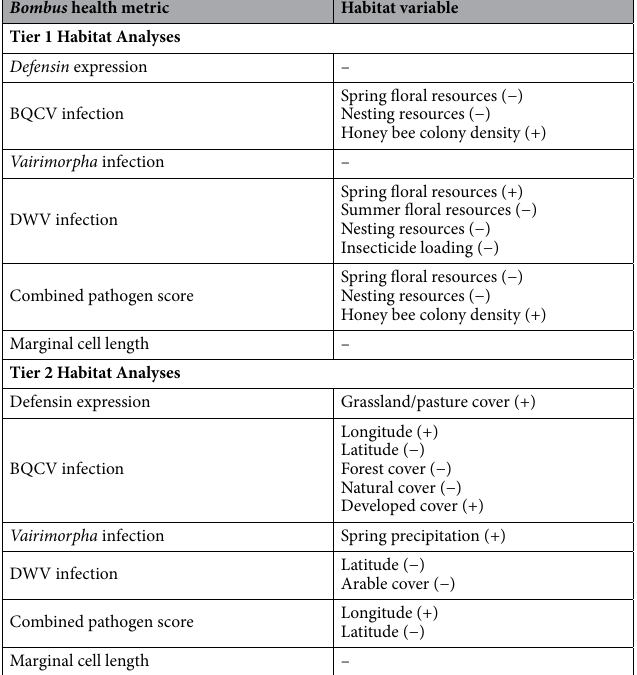
Table 1. Habitat variables associated with metrics of bumble bee ( Bombus impatiens ) health across varied landscapes in Pennsylvania 2018–19. Variables shown below are those with statistical support from our mixed-effects regression analyses (Appendices 1–6) based on Akaike’s Information Criterion adjusted for small sample size and β coefficient 95% confidence intervals (those overlapping zero considered to be weak relationships) in either